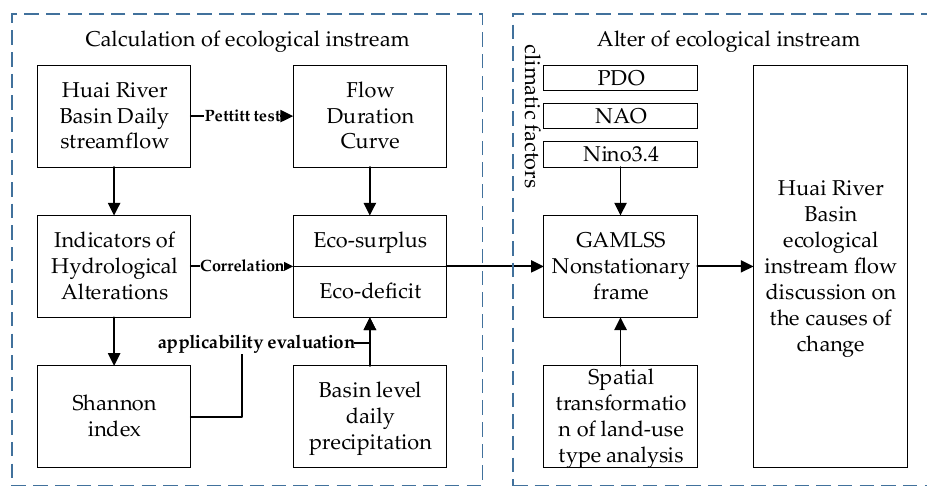
Figure 2. Working procedure for the calculation and change of ecological instream flow.